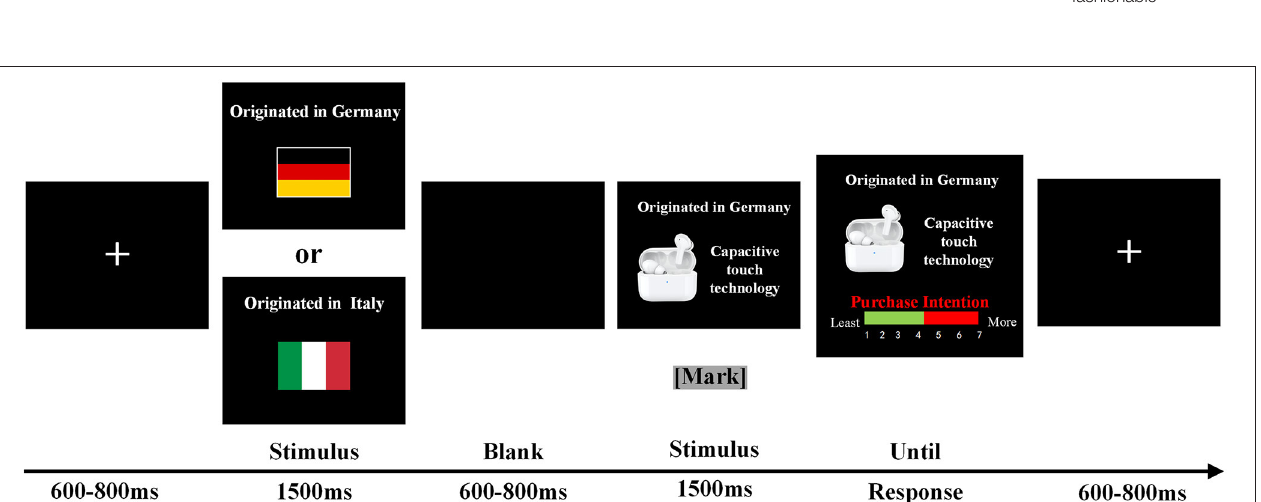
FIGURE 1 | A single trial in the purchase intention task. Each trial began with a fixation cross. Participants viewed the country information for 1,500ms. After a blank screen of 600–800ms, the brand positioning information was presented for 1,500ms. Then, they were asked to give the purchase intention by pressing the corresponding button. EEGs were recorded from the participants throughout the